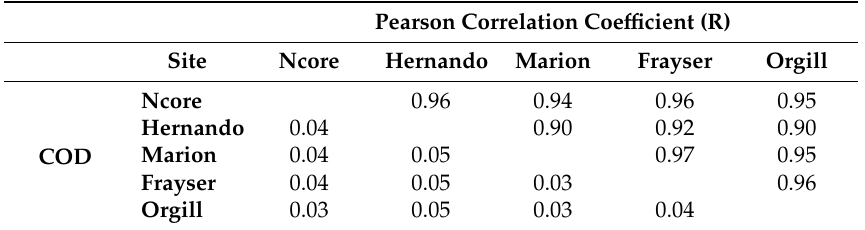
Table 3. Pearson correlation coe ffi cients (Rs) and coe ffi cients of divergence (CODs) of ozone concentrations among five sites in the Memphis Metropolitan